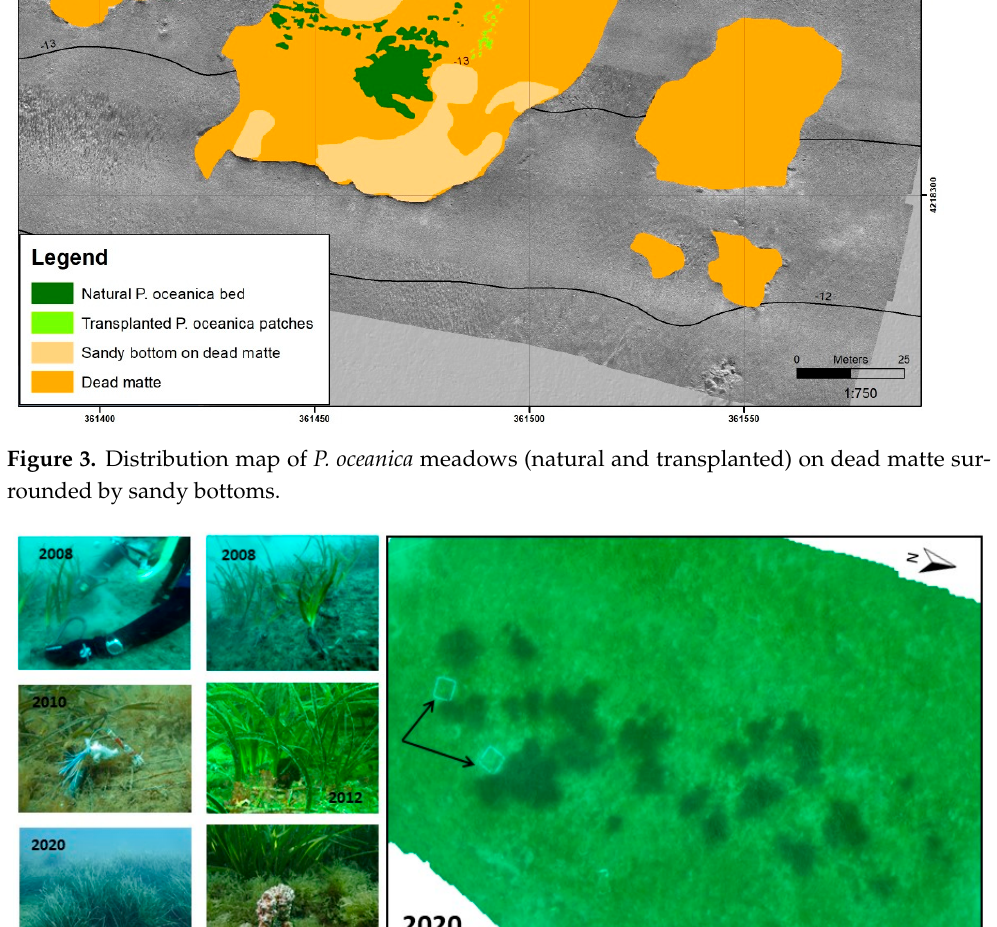
Figure 3. Distribution map of P. oceanica meadows (natural and transplanted) on dead matte sur- rounded by sandy bottoms.